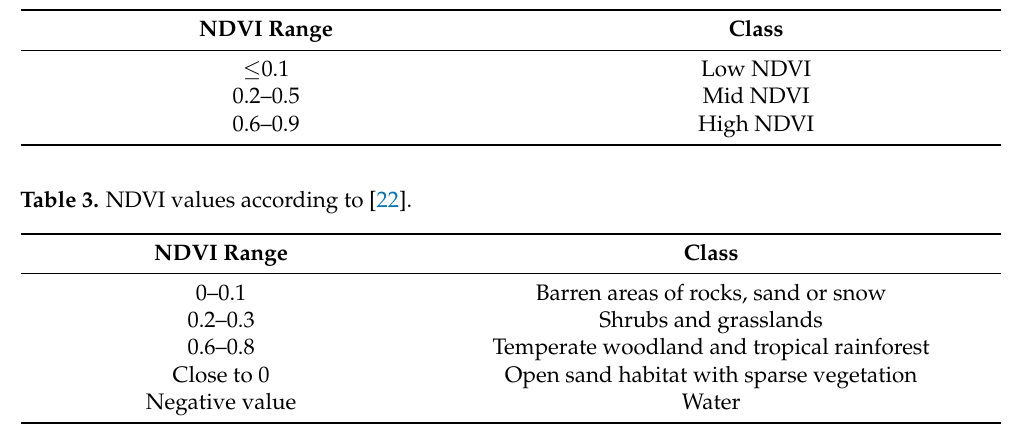
Table 2. Base classification of normalized difference vegetation index (NDVI) values according to remotely sensed phenology [22].